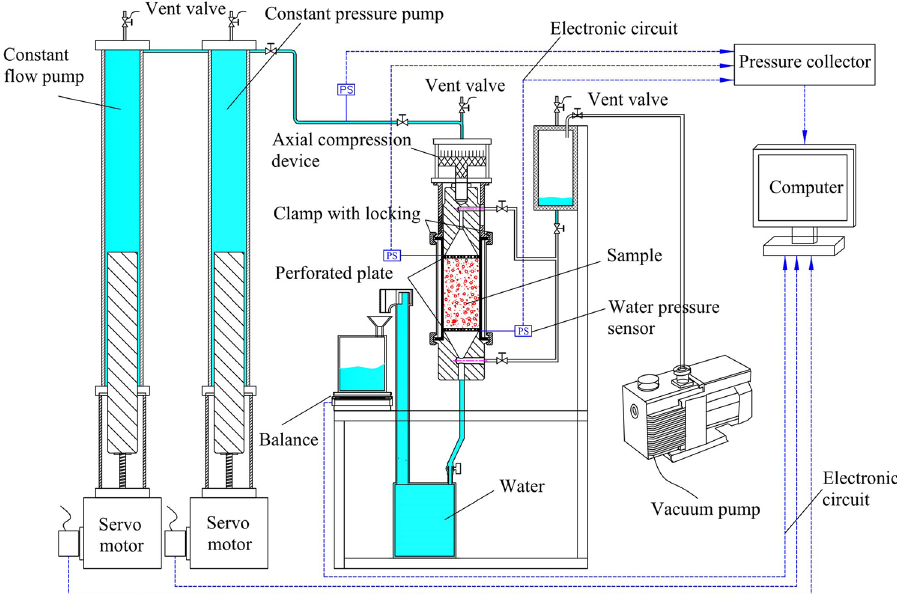
Figure 1. Experimental schematic diagram.